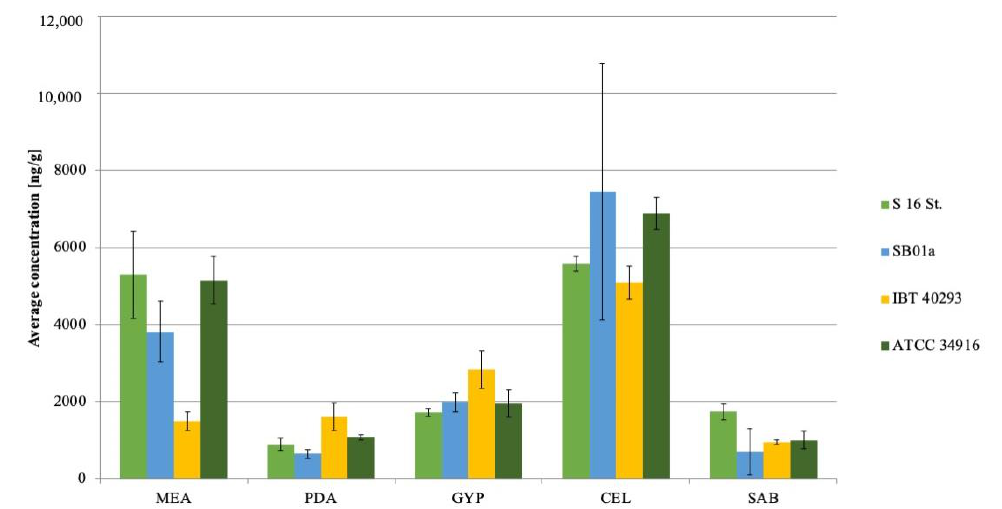
Figure 3. Median concentration ( n = 3) of stachybotrylactam of four di ff erent Stachybotrys chartarum genotype S strains on five di ff erent nutrition media. MEA: Malt-extract-agar; PDA: Potato-dextrose-agar; GYP: Glucose-yeast-peptone-agar; CEL: Cellulose-agar; SAB: Sabouraud-glucose-agar. Supplementary Materials: The following are available online at http: // www.mdpi.com / 2309-608X / 6 / 3 / 159 / s1, Figure S1: Macroscopic appearance of Stachybotrys chartarum genotype S (ATCC34916) on di ff erent nutrition media; Table S1: Recovery rates for macrocyclic trichothecenes and stachybotrylactam on di ff erent nutrition